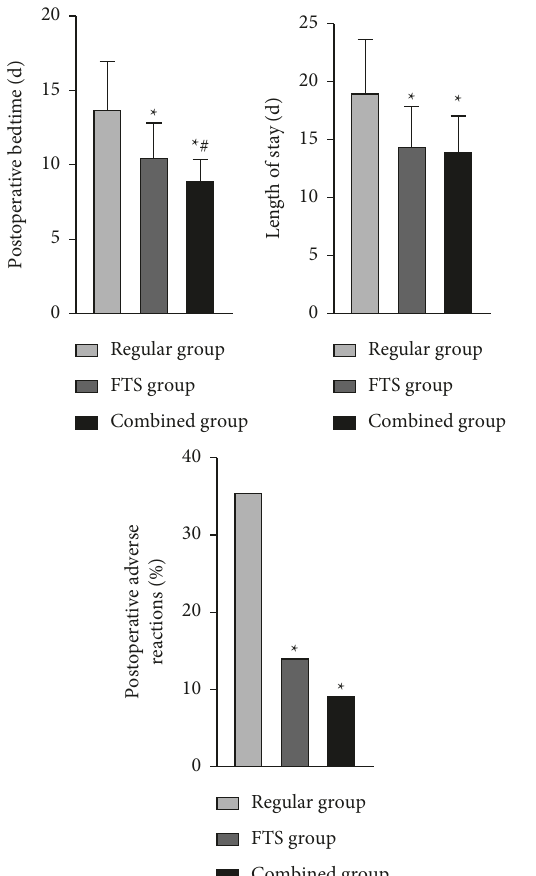
Figure 1: Comparison of postoperative recovery-related indexes among the three groups. Note . Comparison with the regular group, ∗ P < 0 . 05. Comparison with the FTS group, # P < 0 . 05.